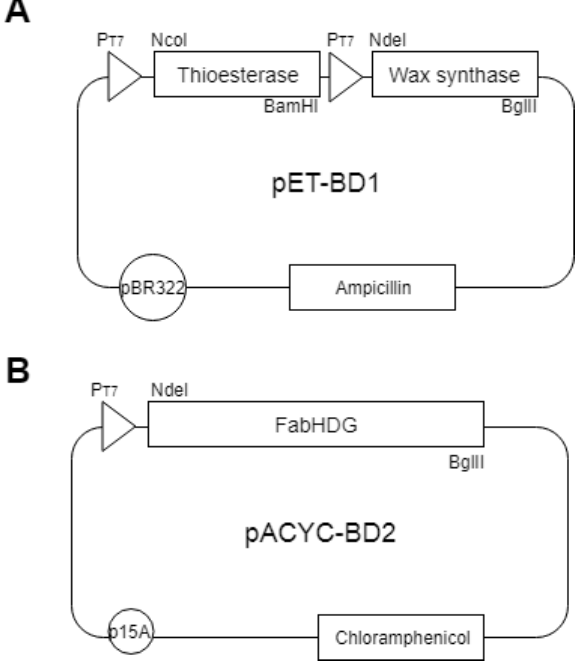
Figure 2. The plasmids. ( A ) pET-BD1 and ( B ) pACYC-BD2.